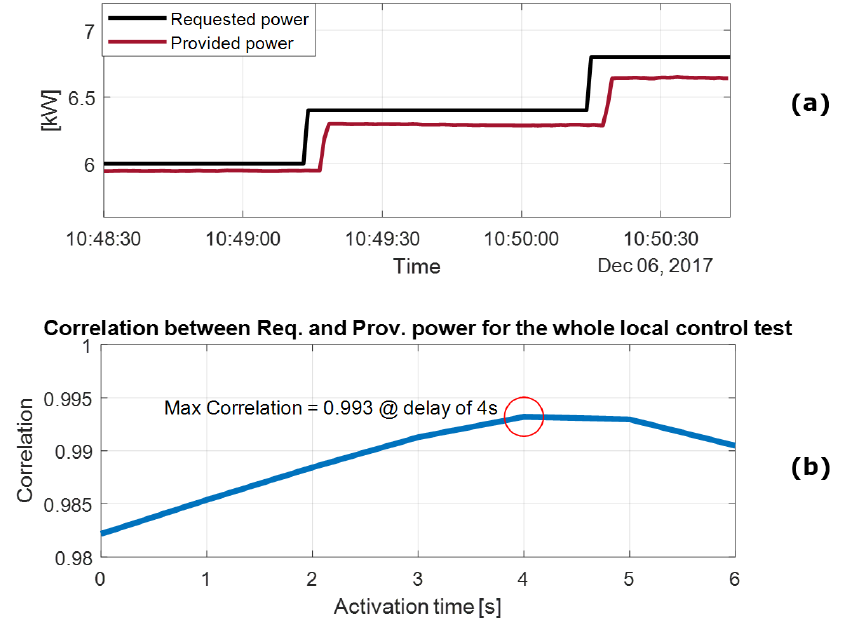
Figure 5. Analyses of the activation time for the local control test: time shift between the requested and the provided power ( a ), and correlation between requested and provided power ( b ). The correlation shows a maximum for a delay of 4 s, which can then be considered as the actual hardware response